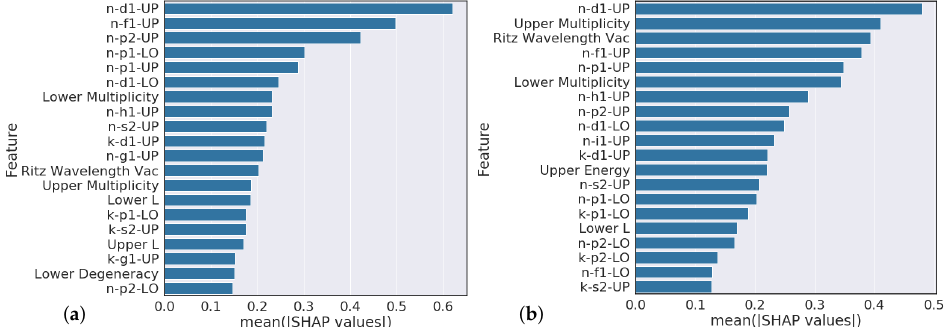
Figure 9. SHAP feature importance results for subsets of transitions for high-performing models (he- lium, aluminum, magnesium, nitrogen, and oxygen) ( a ) Top 10% of transition predictions; ( b ) Bottom 10% of transition predictions. The configuration parameter labels are in the format {n,k}-L#-{UP,LO} where n and k denote if the feature is principle quantum number (n) or occupation number (k), L is the orbital angular momentum with the indexed (#) occurrence in the total configuration, and UP/LO associates it with the upper or lower energy level in a transition.